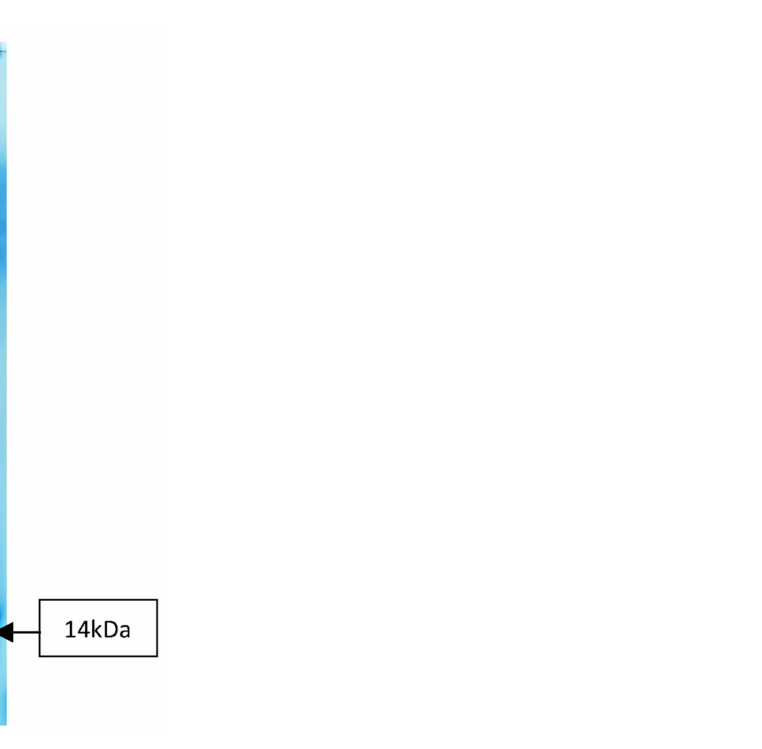
Figure 7. Tricine-SDS-PAGE of the partial purified bacteriocin of Fa17.2. Legend: M: molecular marker (low molecular range marker Promega); Fa17.2 purified peptide extract from B. subtilis Fa17.2